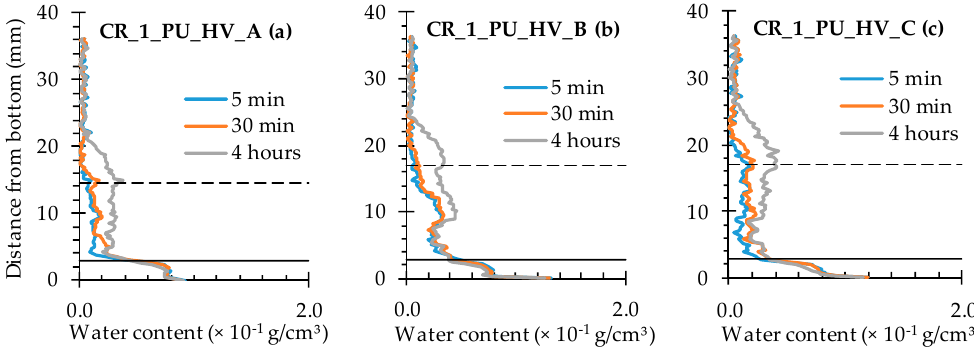
Figure 18. Water profiles along the crack as a function of exposure time for the neutron radiography images of the three standard mortar prisms containing one artificial crack healed with PU_HV: